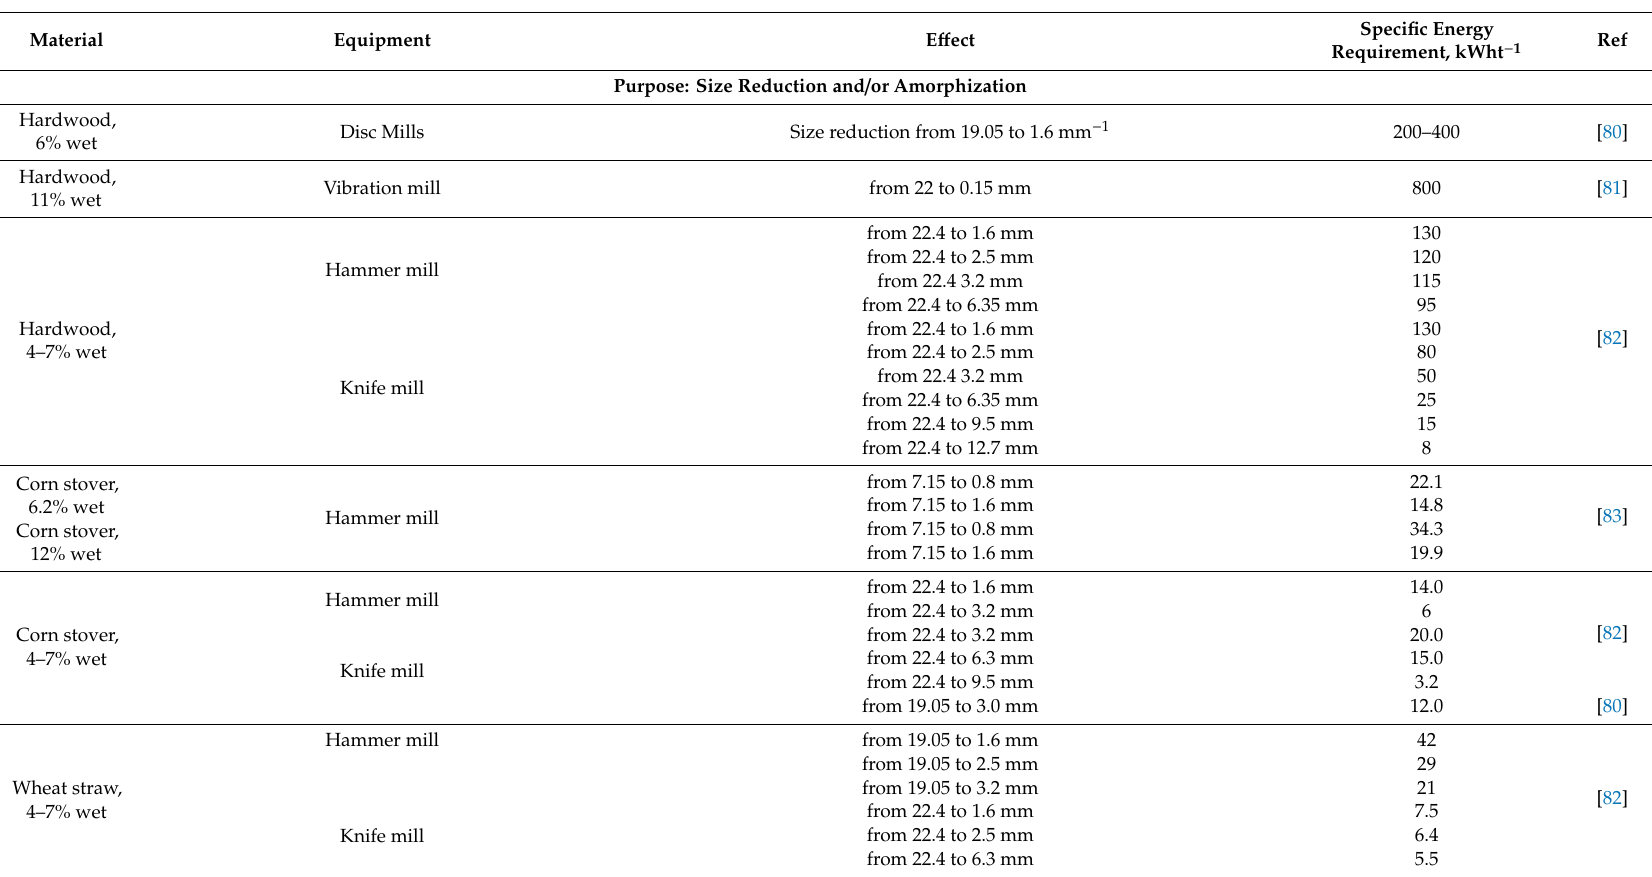
Table 1. The examples of the use of various equipment for the purpose of mechanical (size reduction, amorphization) and mechanochemical